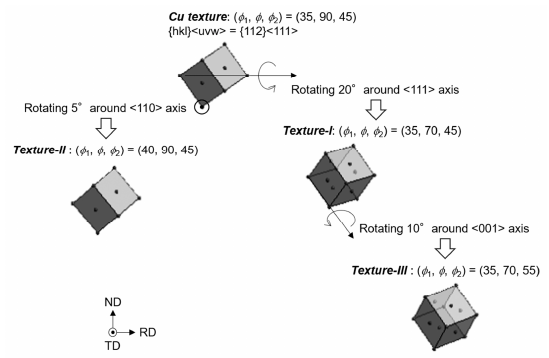
Figure 6. Relationships among the stable directions: Cu texture, texture-I, texture-II, and texture-III.